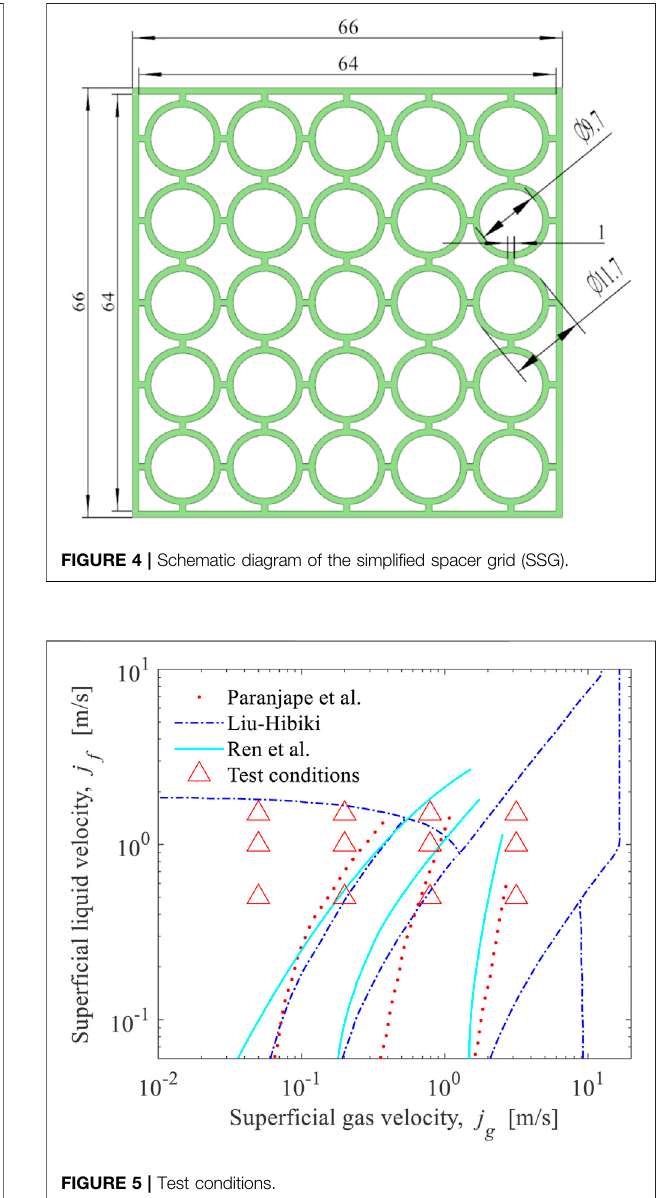
FIGURE 3 | Structure of the test section. (A) Front view. (B) Top view.